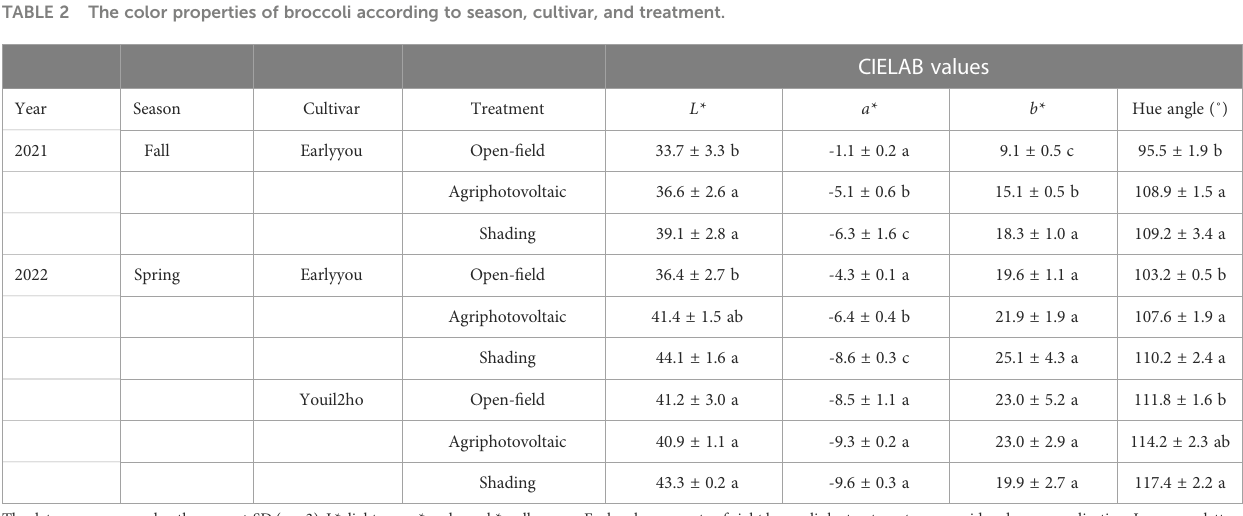
TABLE 2 The color properties of broccoli according to season, cultivar, and